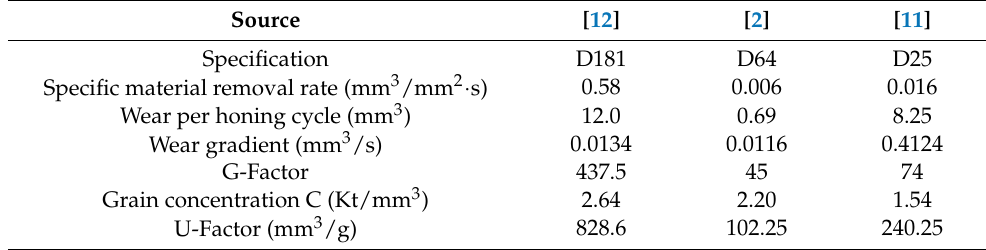
Table 1. Honing stone wear values collected from literature.